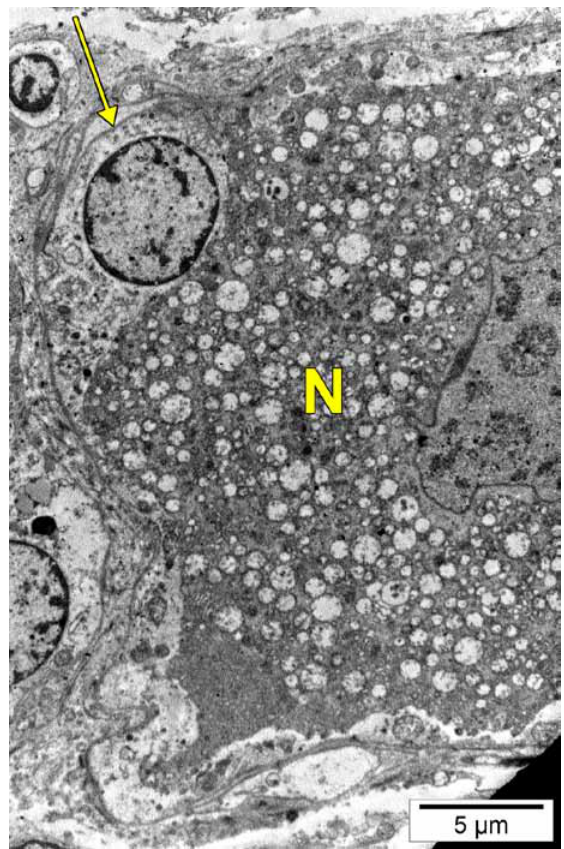
Figure 5. Ultrathin cut of human adult trigeminal ganglion. A trigeminal neuron is presented (N) contacting a differenti- ated SGC